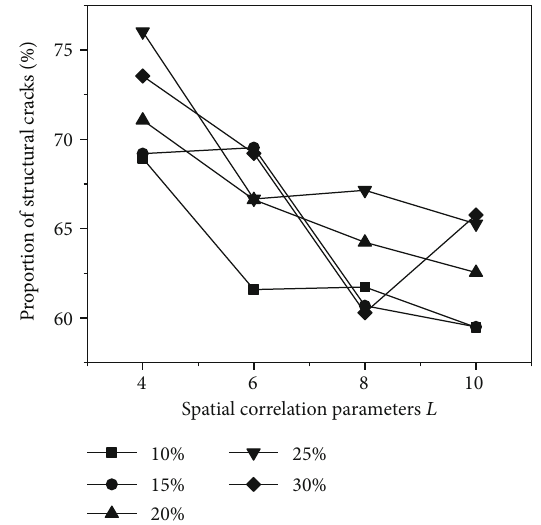
Figure 16: The relationship between the proportion of microcracks and the L